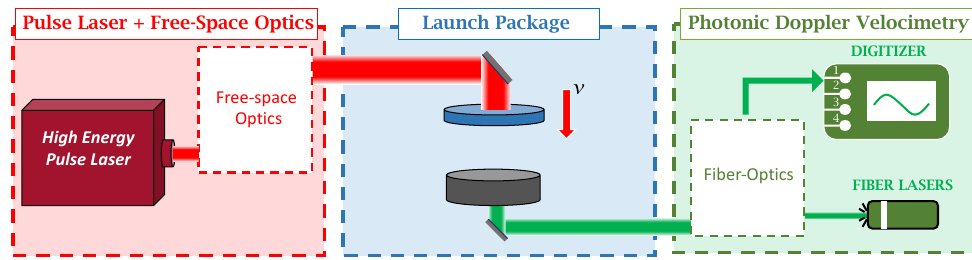
Figure 2. Schematic of Laser-Driven Micro-Flyer experiment. ( Left ) The pulse laser and free-space optics that prepare the laser pulse for optimal micro-flyer launch. ( Center ) The launch package depicting a simplified schematic view of the flyer-specimen impact. The flyer/specimen are not to scale, but typical thicknesses are ∼ 50–200 µ m and diameters are ∼ 1–3 mm. ( Right ) A schematic of the PDV measurement